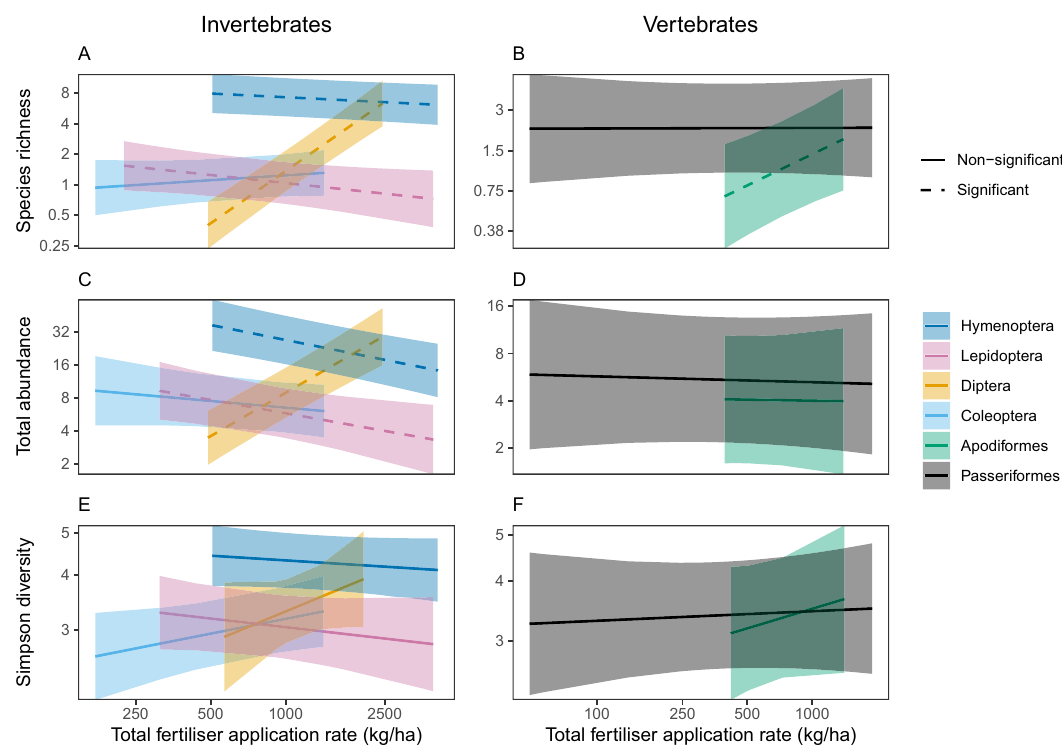
Fig. 5 Response of pollinator biodiversity in cropland sites to total fertiliser application rate in the landscape (kg/ha) (note that each metric is plotted on a log scale), predicted across 95% of the range of sampled fertiliser values for each taxonomic order. Each panel represents a linear or generalised linear mixed-effects model for a given biodiversity metric for four invertebrate orders: A , C , and E invertebrate species richness, total abundance, and Simpson diversity respectively; and B , D , and F vertebrate species richness, total abundance, and Simpson diversity respectively. Coloured lines represent median fi tted estimates for each taxonomic order, with shading representing 95% con fi dence intervals: light blue (Coleoptera), light orange (Diptera), dark blue (Hymenoptera), pink (Lepidoptera), green (Apodiformes), and black (Passeriformes). Dashed lines represent signi fi cant interactions ( p < 0.05) between taxonomic order and total fertiliser application rate, and solid lines non-signi fi cant interactions. See Supplementary Table 15 for the number of sites, Supplementary Tables 16, 17, and 18 for the model summaries, and Supplementary Fig. 9 for the global distribution of total fertiliser application rate. Source data are provided as a Source Data fi